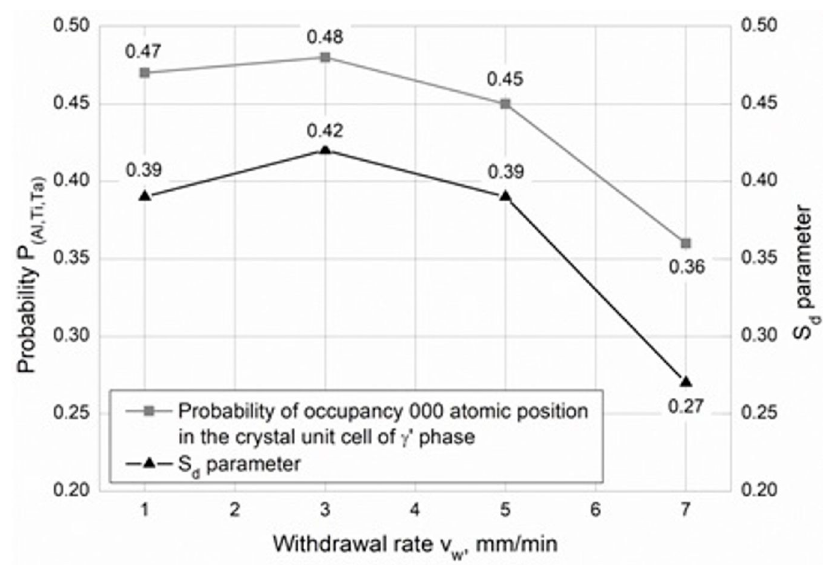
Figure 5. Values of probability of occupancy of the 000 atomic position by Al, Ti and Ta and S d parameters as a function of the withdrawal rate.